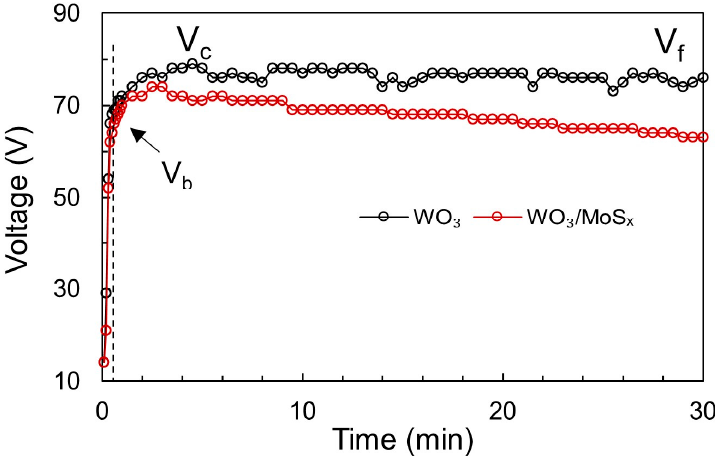
Figure 1. Voltage vs. time plots obtained for PEO of W at 25 mA cm − 2 during synthesis of WO 3 and WO 3 /MoS x heterostructures in the respective electrolytes.